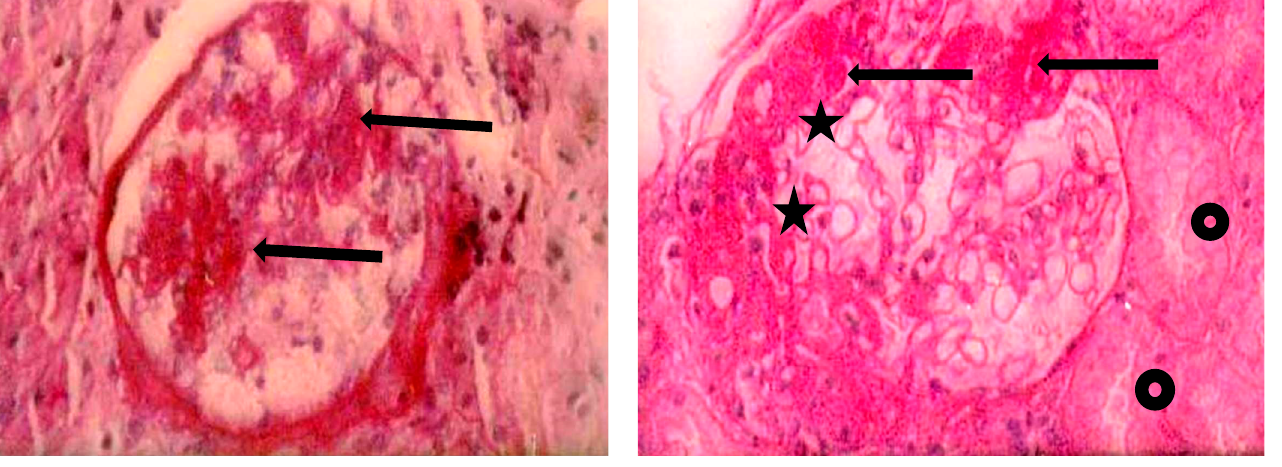
Figure 2. Patient 2. Renal Biopsy shows glomerular sclerosis (black arrow), open capillary wings (  ) and Renal tubules with partially occluded ligths (  ).